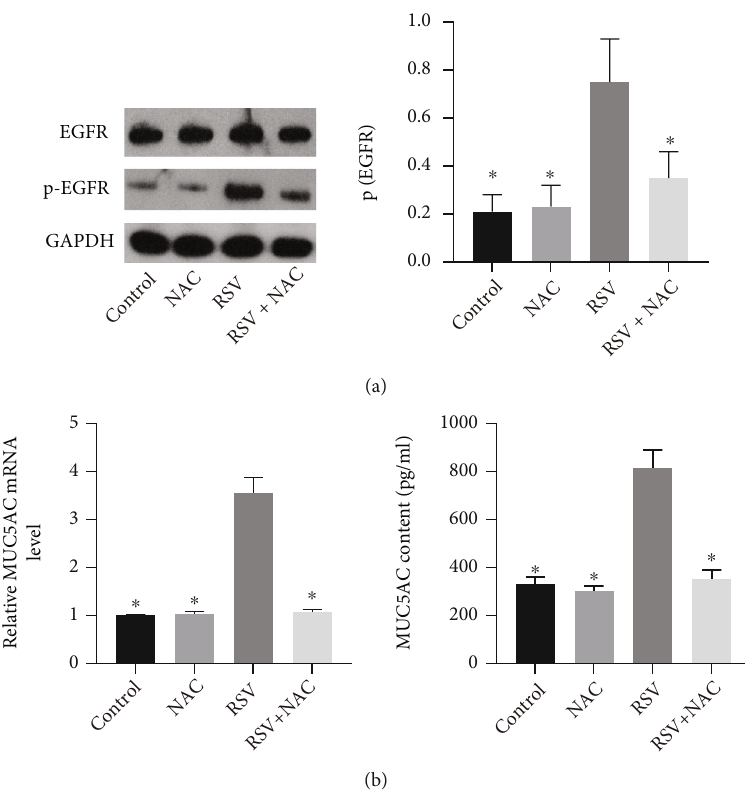
Figure 4: NAC inhibits EGFR activation and mucin synthesis in RSV-infected BEAS-2B cells. (a), Immunoblotting analysis of EGFR and p- EGFR in RSV-infected BEAS-2B cells. (b), Quantitative real-time PCR and ELISA detection of MUC5AC mRNA expression and MUC5AC contents. ∗ indicates p < 0 : 05 compared with RSV